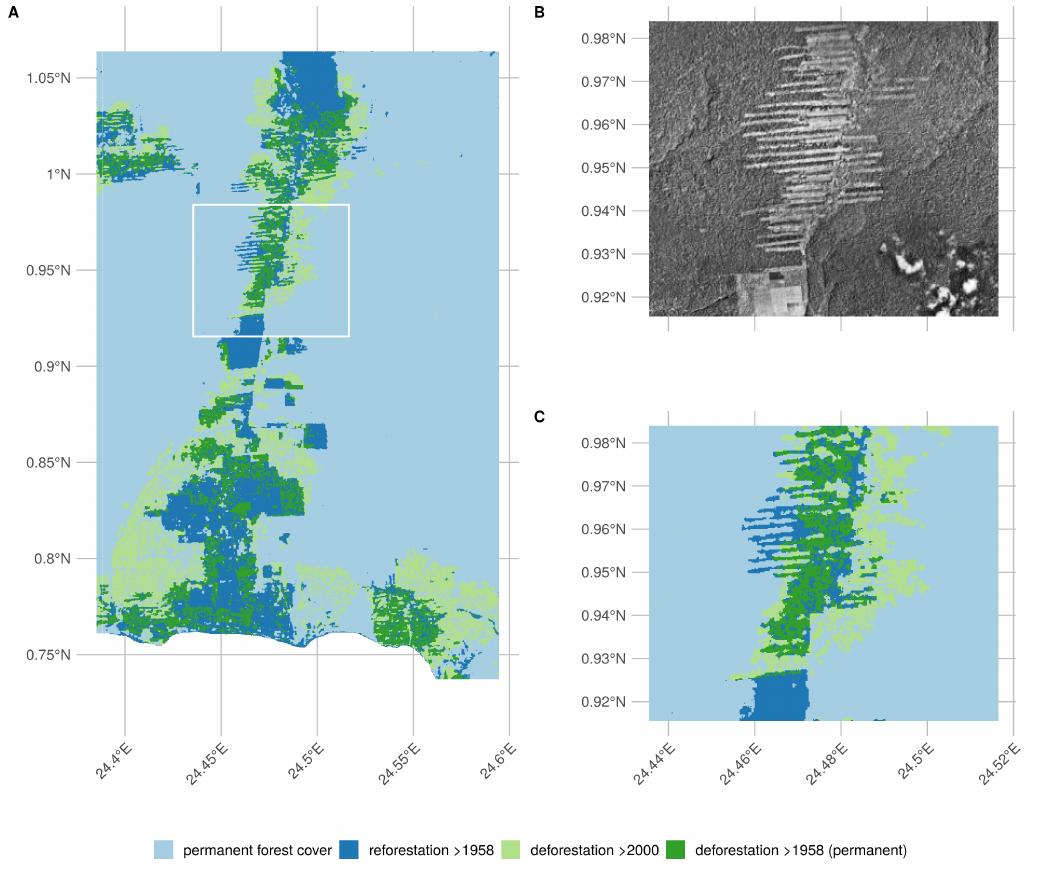
Figure 5. Overview of the final land-use land-cover change map ( A ), a detailed inset of both the underlying orthomosaic ( B ) and the derived land-use land-cover change map displayed as the difference between the convolutional neural network-based classification orthomosaic and the recent Landsat-based forest cover map by Hansen et al. 2013 ( C